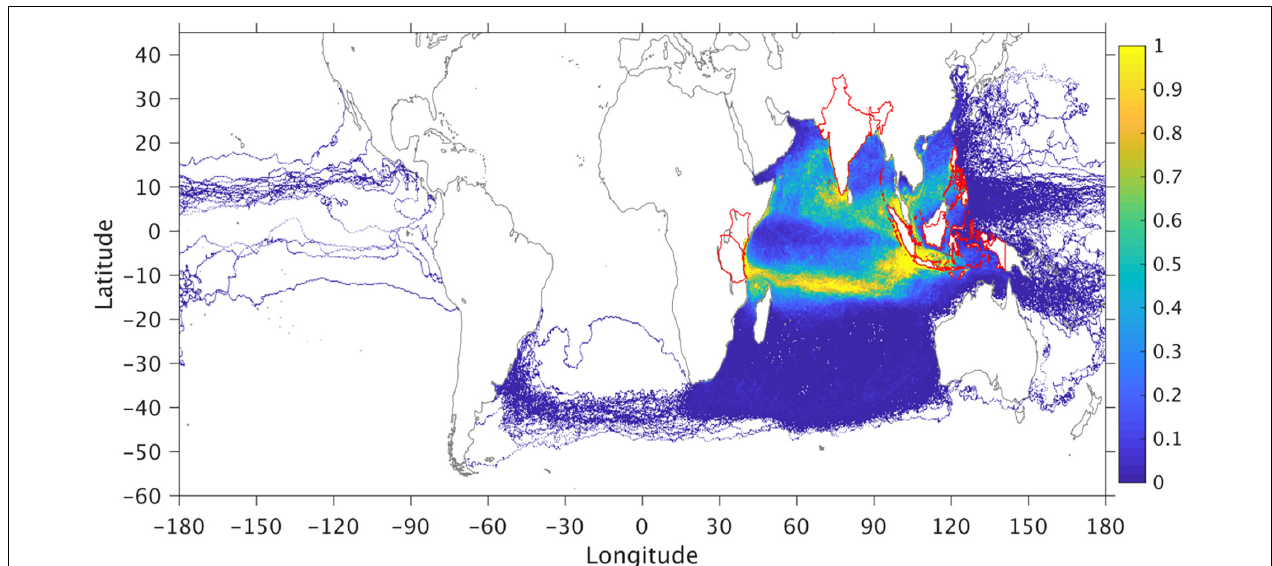
FIGURE 8 | Time-averaged model mismanaged plastic waste concentration (in kg/km 2 ) in the ocean in 2010-2019 for the MPW that are beached on the Kenyan coast by the end of 2019. Red lines outline the border of the five countries that contribute the most mismanaged plastic waste to Kenya (Tanzania, Indonesia, India, Philippines, and Kenya; see Table 2 ).